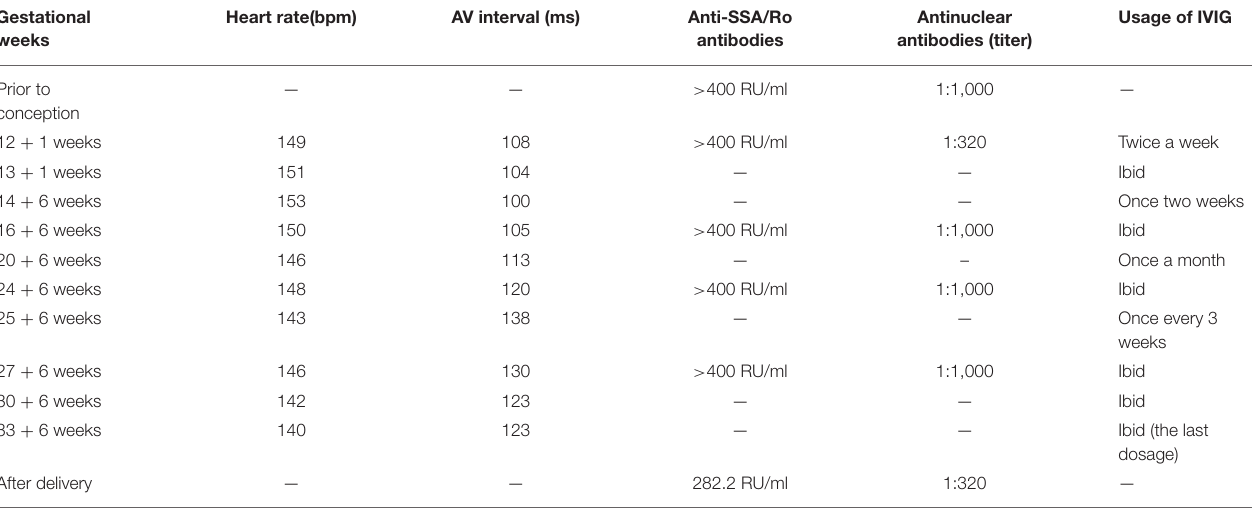
TABLE 1 | Monitoring of the fetal HR, AV interval, maternal serum antibody and medication during pregnancy. Gestational Heart rate(bpm) AV interval (ms) Anti-SSA/Ro weeks